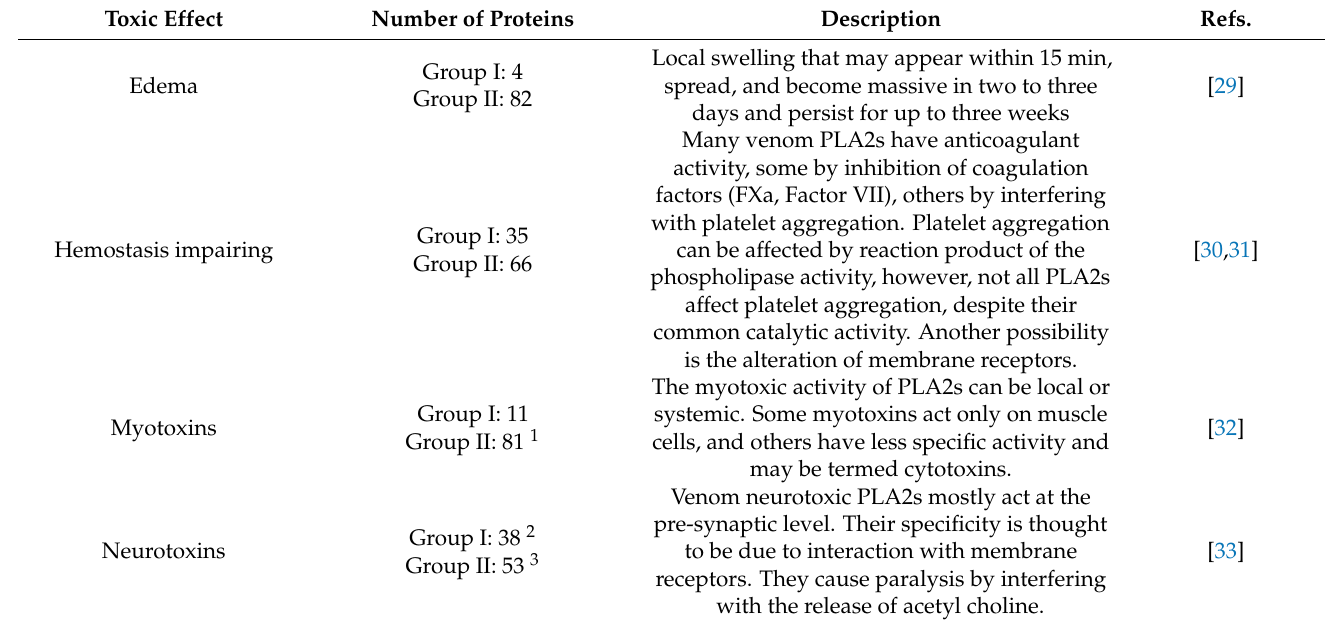
Table 2. Main toxic effects caused by animal venom PLA2s, and number of proteins having that toxic property. Data were obtained through an advanced search in UniProtKB, selecting the protein family (phospholipase A2), the taxonomy (serpentes), and the keyword corresponding to the type of